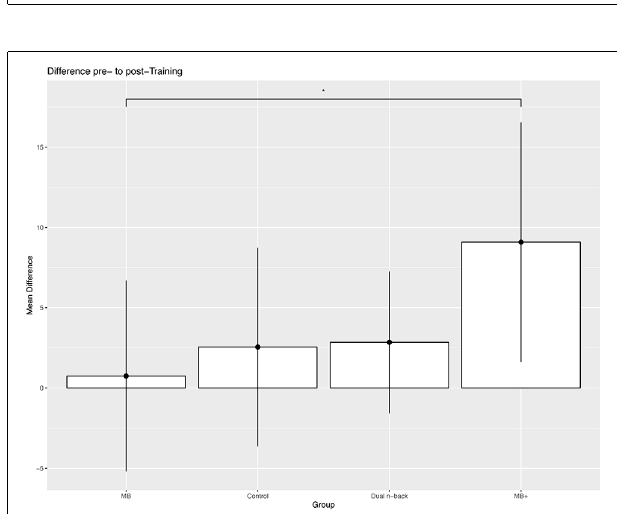
FIGURE 4 | Representation of the mean difference of the complex span composite score between pre- and post-training in all training groups.